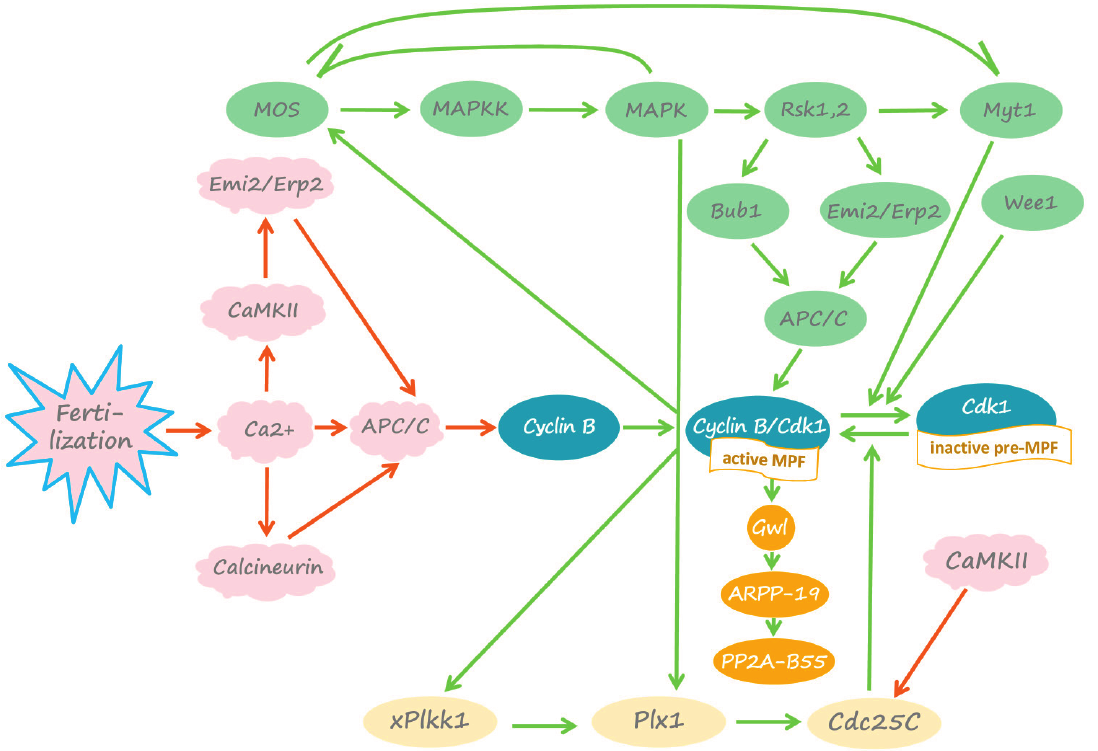
Figure 1. Signaling pathways in metaphase-arrested and fertilized Xenopus eggs. Molecular components of the signaling pathways operating in mature metaphase-arrested eggs and the factors involved in fertilization-induced exit from meiotic metaphase arrest are shown connected by green and red arrows, respectively. Detailed explanations are provided in the text (see Sections 2 and